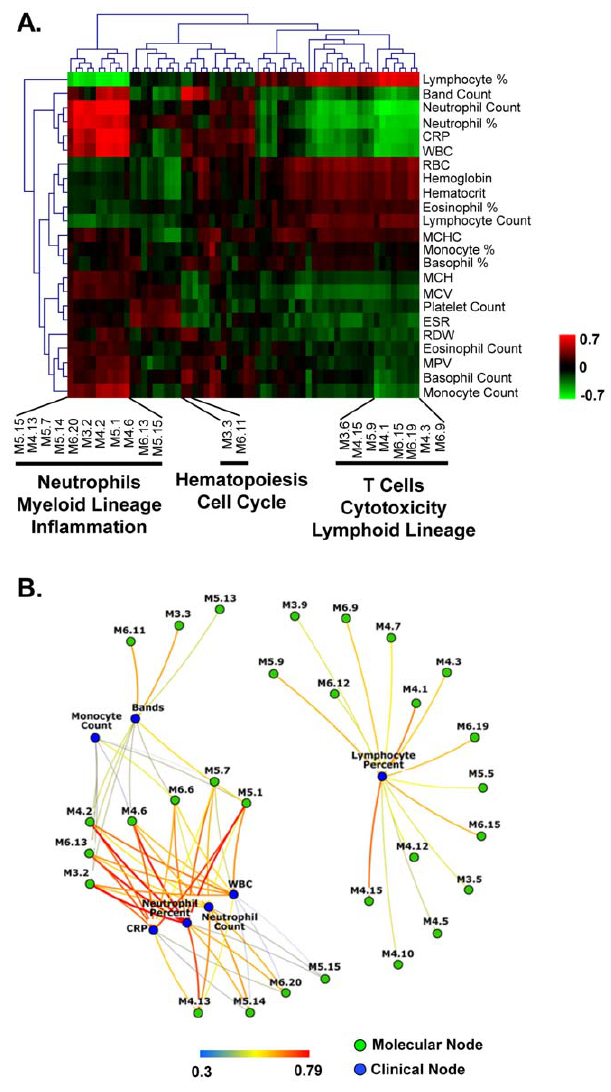
Figure 3. Specific module subsets correlate with laboratory results. A. Heatmap representing correlation (Spearman R) between module percent expression in columns and continuous laboratory parameters in rows. Hierarchical clustering (Euclidian distance) was applied in both dimensions. B. Connection network representing correlation between molecular nodes (modules) in blue and clinical nodes (laboratory parameters) in green. Spearman R correlation greater than 0.3 are